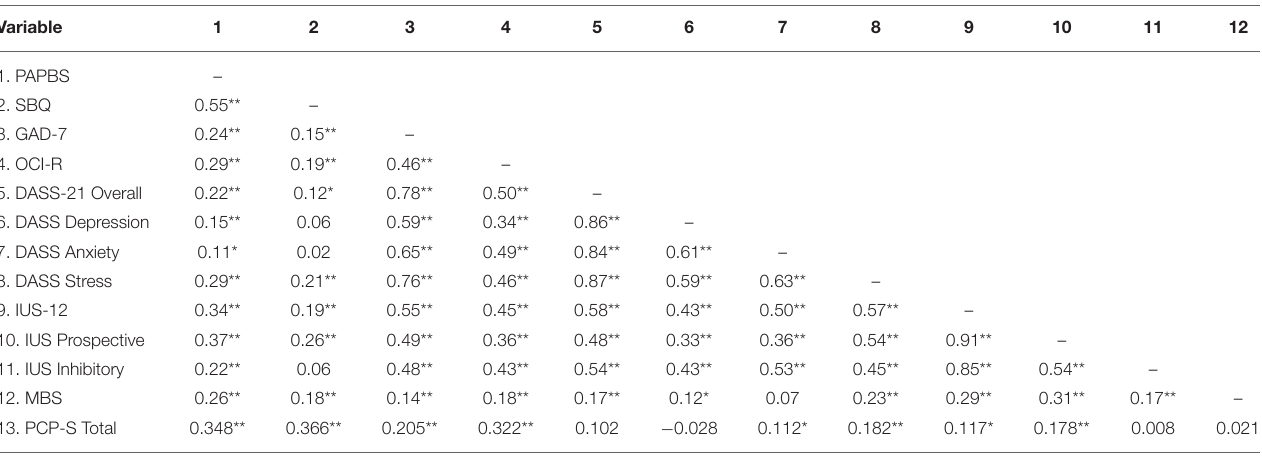
TABLE 5 | Correlations for Study Variables ( N = 373). Variable